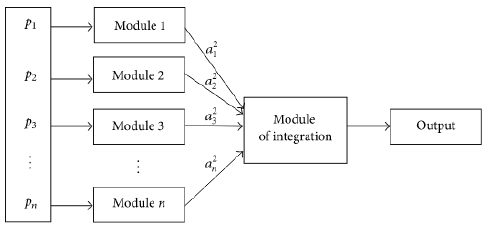
Figure 4. The structure of the MNN